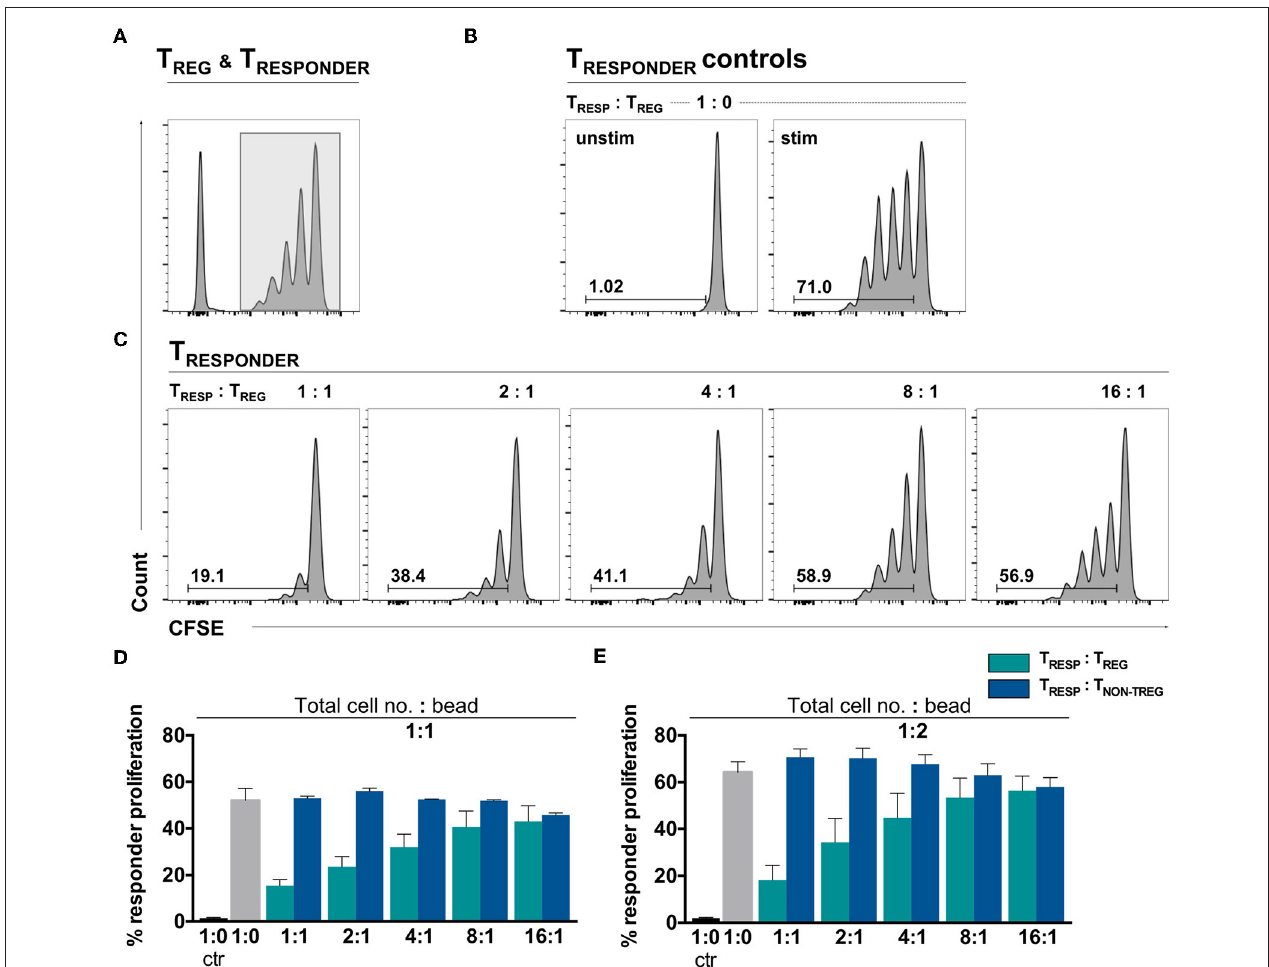
FIGURE 2 | Ex vivo isolated T REG demonstrate a dose-dependent T RESP proliferation suppression in a bead-uncompetitive setting. FACSorted CFSE + CD4 + CD25 − T RESP were co-cultured with autologous FACSorted T REG and stimulated with anti-CD3/CD28-coated microbeads for 96h. T RESP proliferation was analyzed by CFSE dilution. Representative plots depicting (A) CFSE-labeling strategy to accurately analyze T RESP proliferation; (B) proliferation of unstimulated and stimulated CFSE + T RESP cultured without T REG and (C) CFSE + T RESP proliferation after co-culture with different T REG ratios. (D) Percentage of T RESP proliferation after co-culture with decreasing T RESP :T REG ratios (green bars) and T RESP :T NON - TREG ratios (blue bars) stimulated with a total cell number:bead ratio of 1:1. n = 7 T RESP :T REG co-cultures, n = 3 T RESP :T NON − TREG co-cultures. (E) Percentage of T RESP proliferation after co-culture with decreasing T RESP :T REG ratios (green bars) and T RESP :T NON - TREG ratios (blue bars) stimulated with a total cell number:bead ratio of 1:2. n = 3. Median data of independent experiments are shown and error bars represent